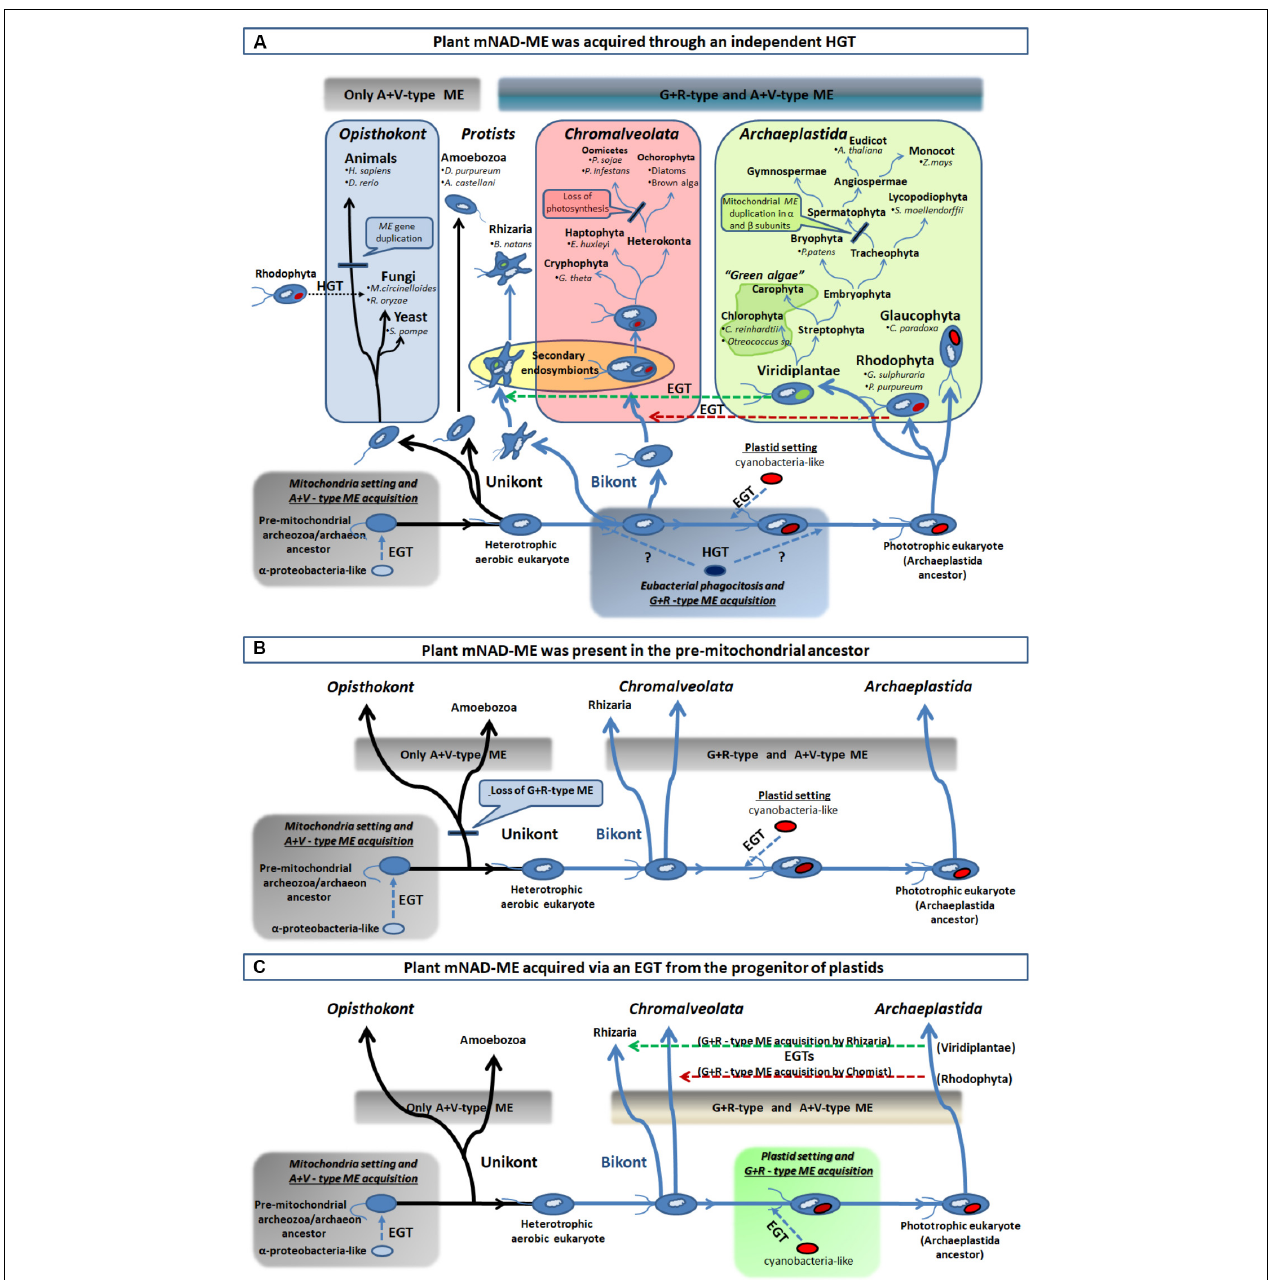
FIGURE 6 | Different scenarios of acquisition of the R+G clade of Class I-ME in eukaryotes. (A) From bottom left, an extensive EGT from an engulfed α -proteobacteria-like ancestor (mitochondria precursor) to the nucleus of a unikont (one flagellum) host took place. This resulted in the establishment of eubacterial ME version in early eukaryotes and the foundation of the A+V clade of ME. After unikont and bikont (two flagella) splitting and prior – or post – plastid setting (indicated by question marks), an HGT event from one eubacteria (possibly a γ -proteobacteria-like) into the Archaeplastida ancestor established the G+R clade of Class I-MEs in eukaryotes. This allowed spreading of G+R isoforms in all primary photosynthetic organisms, as well as, in the secondary phototrophs (Chromalveolata and Rhizaria) via an EGT (green and red horizontal broken line arrows) and in some fungi by an HGT event (black horizontal dotted line arrow). (B) The G+R ME could be the ancestral isoform that was present in the pre-mitochondrial, and founder of the eukaryotic lineage, ancestor (the “Archezoa,” or an autotrophic methanogenic archaeon, depending on the model for the evolution of eukaryotes). The establishment of mitochondria in this ancestor allowed the acquisition of an additional isoform (the type A+V) and this chimeric structure for the MEF was maintained by the bikont lineage. However, only the A+V-type ME was retained by the unikont ancestor, as it lost the more ancestral isoform in what could have been a genetic replacement. (C) The G+R ME acquisition by photosynthetic organisms (containing the A+V ME derived from the mitochondria setting) may have taken place in with the plastid genesis, through the extensive EGT from the engulfed cyanobacteria to the host genome. Hence, the presence of this isoform in secondary phototrophs organisms results from secondary endosymbiosis processes, as is explained in A . For clarity, the major taxa of eukaryotic organisms were omitted in B and C .